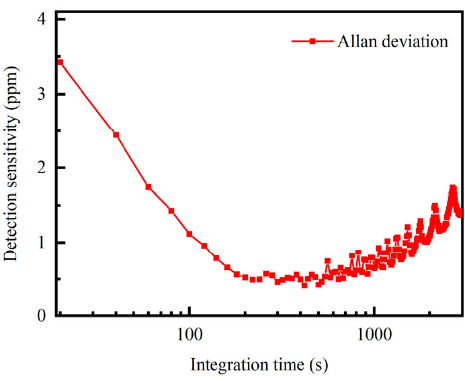
Figure 8. Allan deviation analysis of the amplitude of normalized 2 f photoacoustic signal.